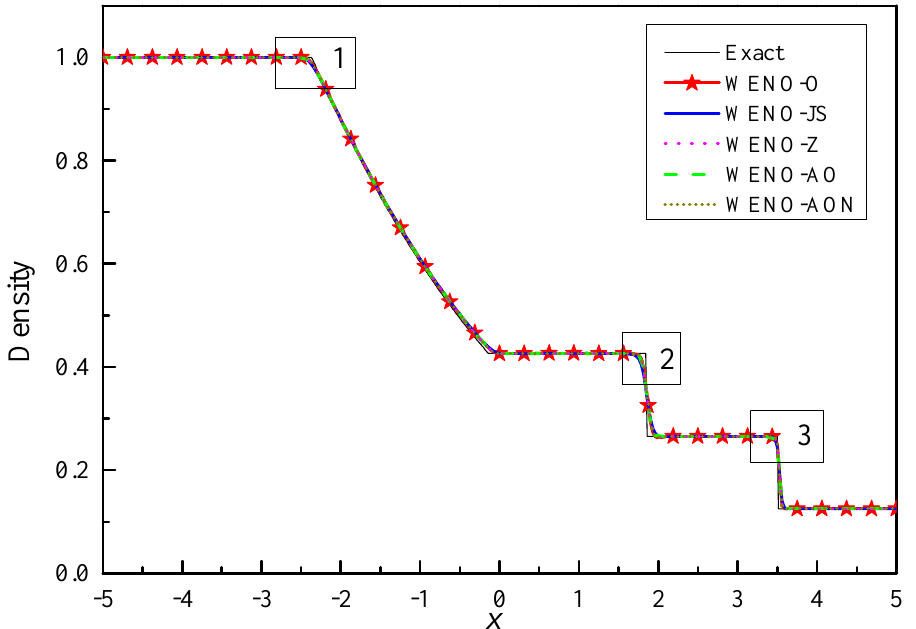
Figure 15. Numerical results of Sod’s problem of Example 5 (Section 6.2.2) for density field at time t = 2, CFL = 0.1 with 320 cells for the considered WENO